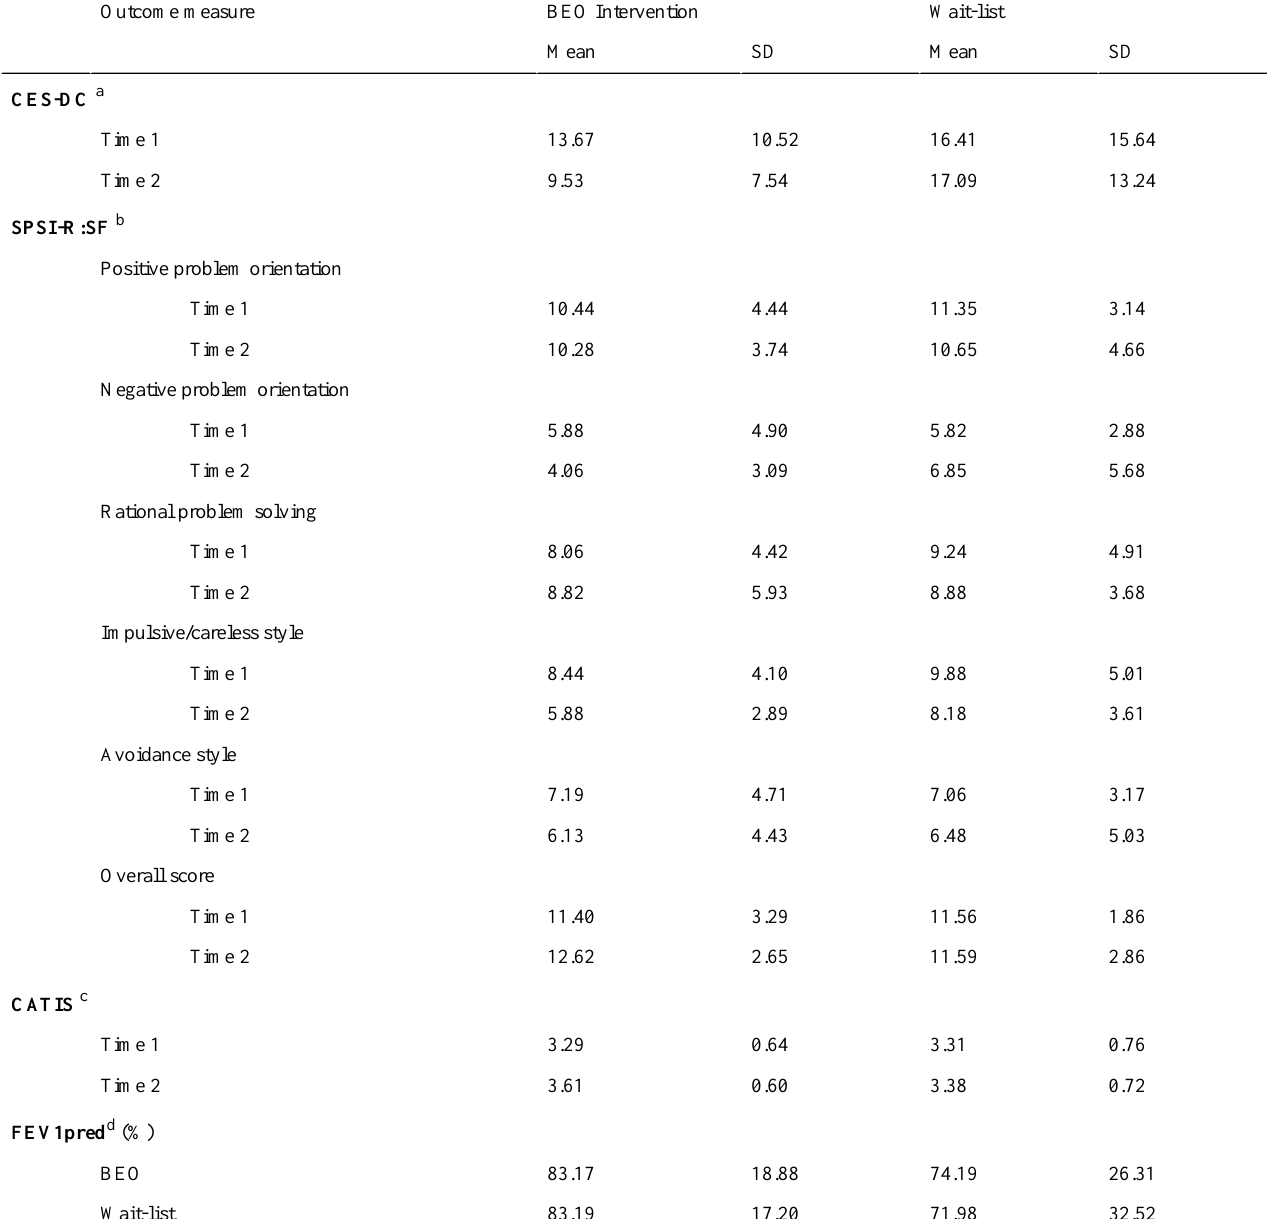
Table 2. Descriptive statistics on outcome measures for children and adolescents for Breathe Easier Online (BEO) intervention and wait-list control